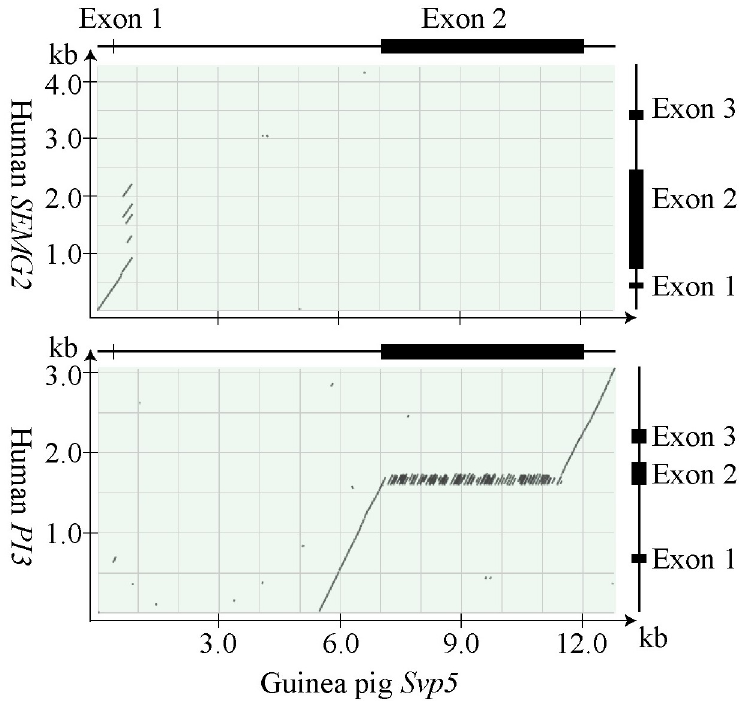
Fig 5. Homology of guinea pig Svp5 and human SEMG2 and PI3 . The dotplots are made with the results of BLAST alignments, showing homology with SEMG2 in the 5’ end and PI3 in the 3’ end of Svp5 . The lines at the top and to the right of the dotplots illustrate genes, with boxes depicting the location of